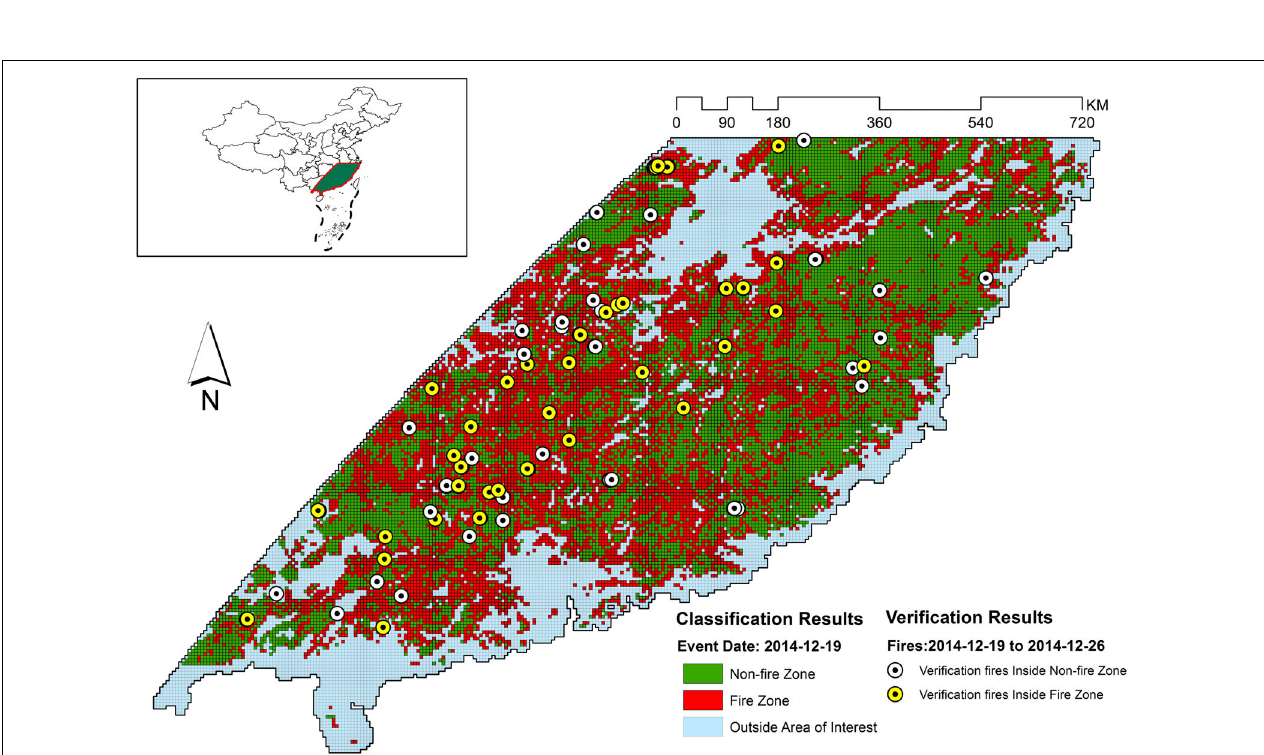
FIGURE 12 | Classification and verification results for